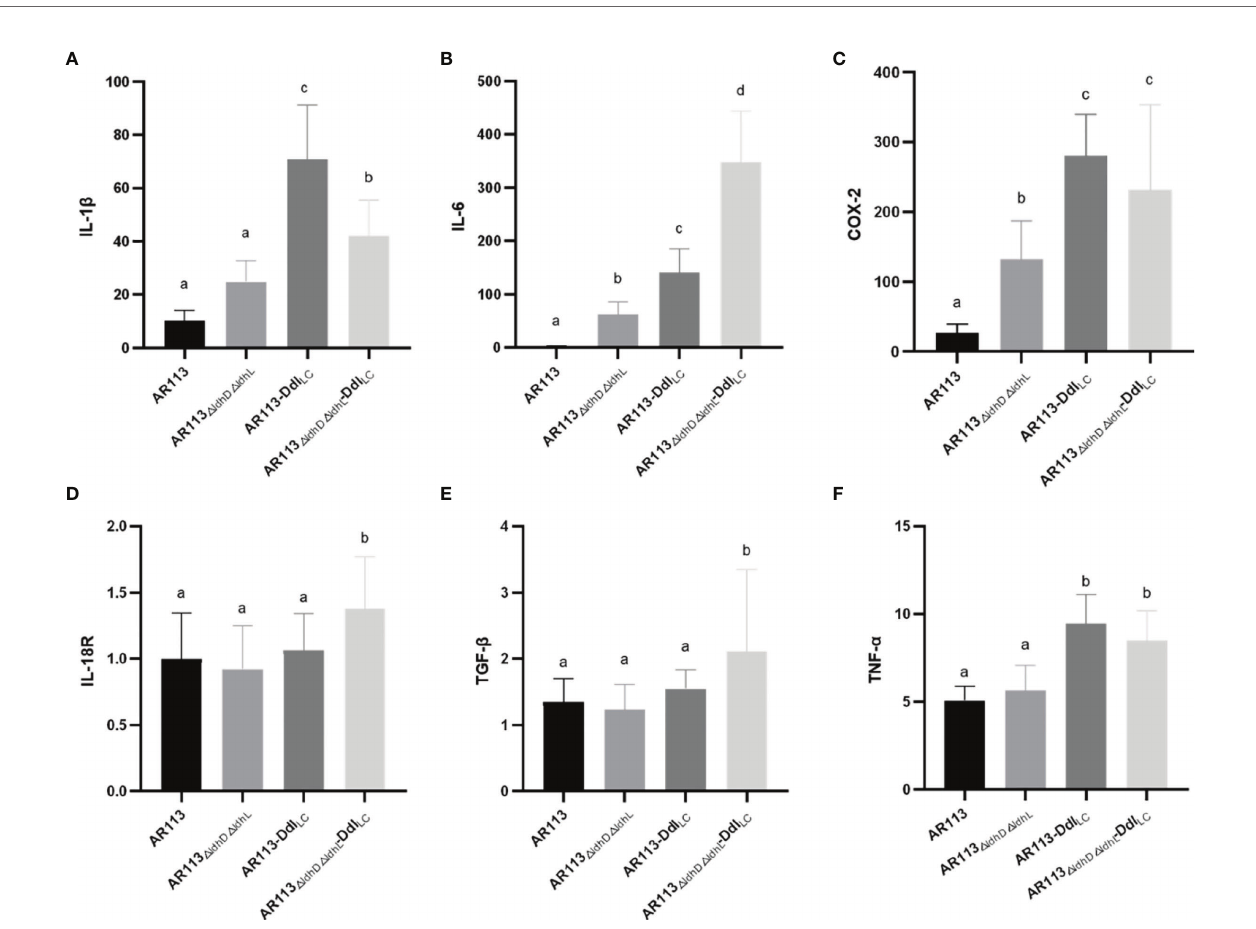
FIGURE 5 | Effects of D-Ala-ended peptidoglycan precursors on the expression of cytokine/in fl ammatory factor genes (A) IL-1 b , (B) IL-6, (C) COX-2, (D) IL-18R, (E) TGF- b and (F) TNF- a in macrophages. The statistical analyses were assessed using one-way ANOVA. Data are represented as means ± standard deviations (n = 7). Data indicated with different letters differ signi fi cantly (P <